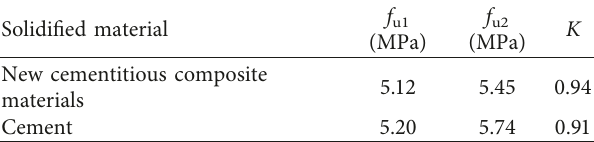
Table 7: Test result of the water stability of solidified